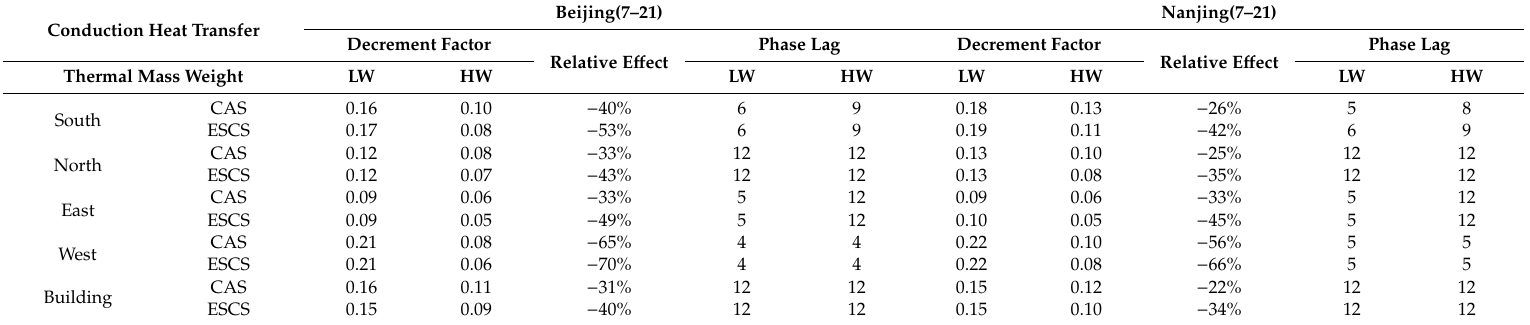
Table 2. The e ff ects of thermal mass on thermal transmission (cooling design days).